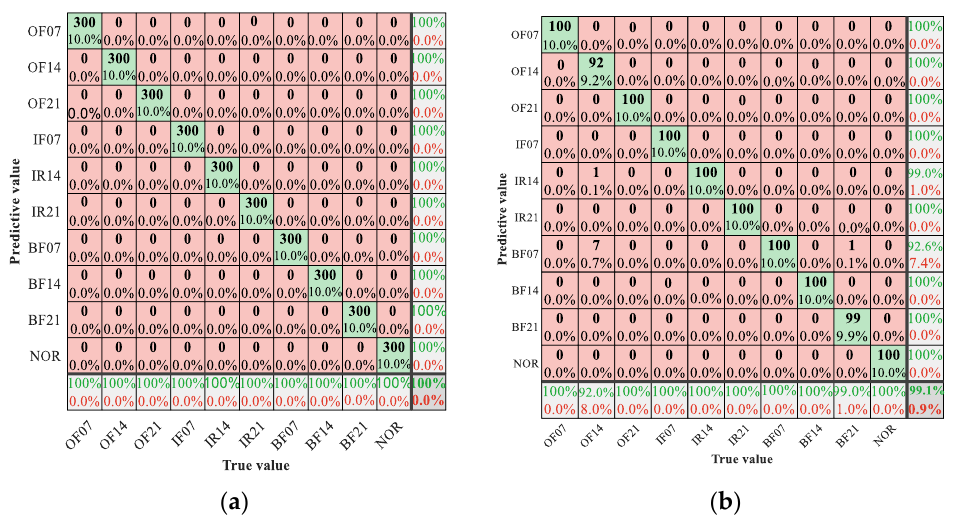
Figure 9. The diagnostic confusion matrix of AD-RBF-ELM model (Western Reserve University): ( a ) The confusion matrix of training set. ( b ) The confusion matrix of testing set. Table 4. Diagnostic rate of different models (Western Reserve University).